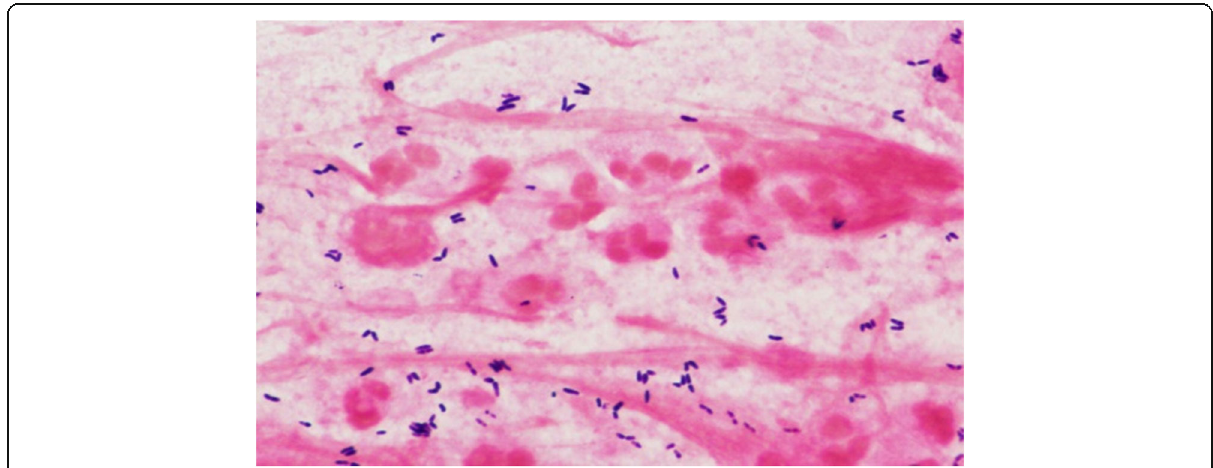
Fig. 1 Gram-stain observed in sputum from patient with Corynebacterial pneumonia. A sputum sample collected from the patient in Case 1 depicts Gram-positive bacilli (purple) within and surrounding polymorphonuclear cells (pink). The “ club-shaped ” appearance pathognomonic